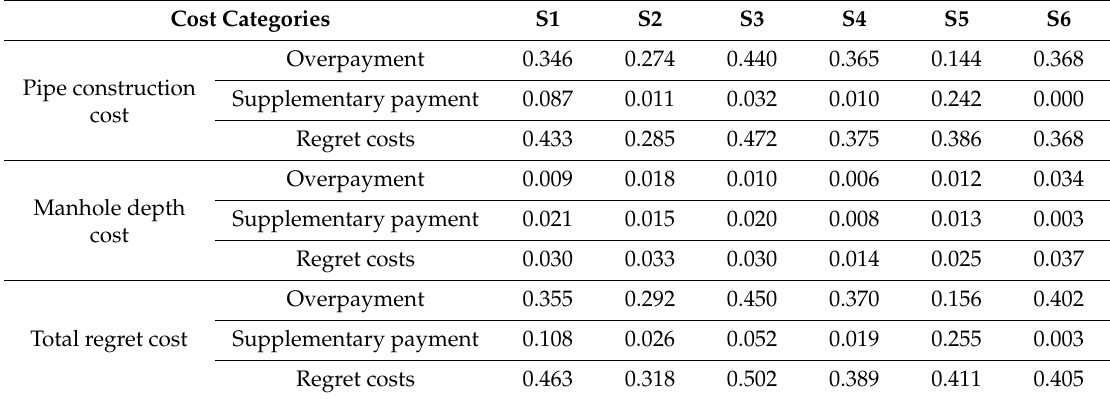
Table 4. RC analysis of the multi-scenario-based planning solutions (Phase